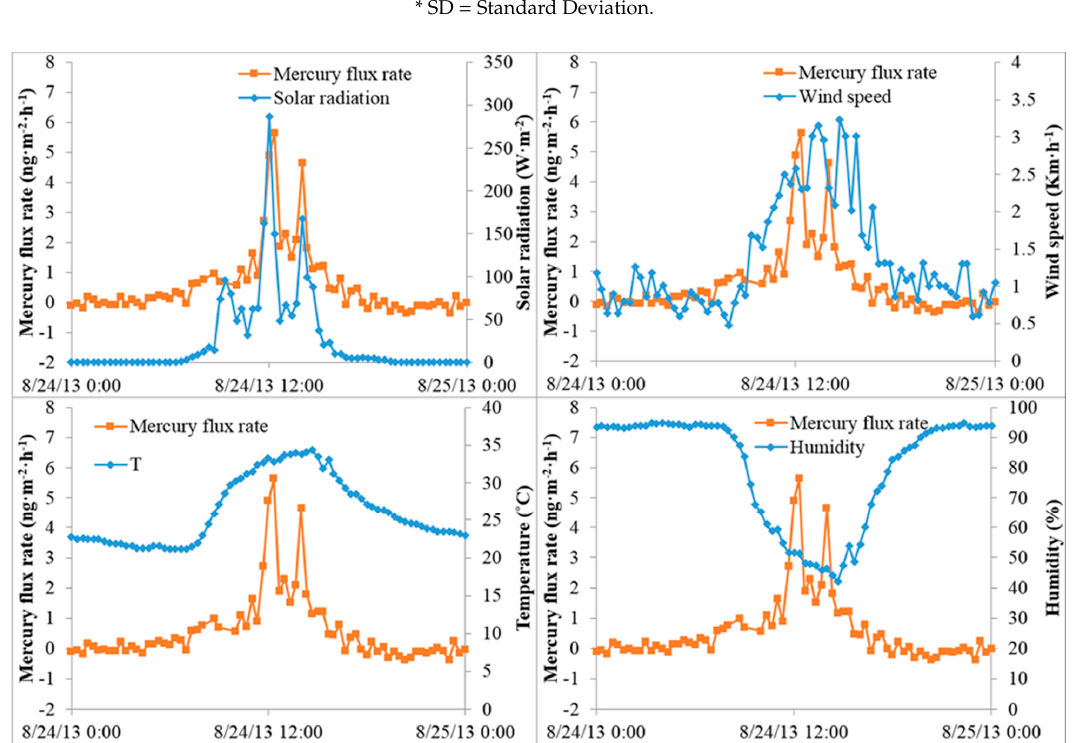
Figure 2. Relationship between gaseous elemental mercury (GEM) flux and solar radiation ( top left ), wind speed ( top right ), air temperature ( lower left ), and humidity ( lower right ) at a loblolly pine forest in Mississippi during the summer.